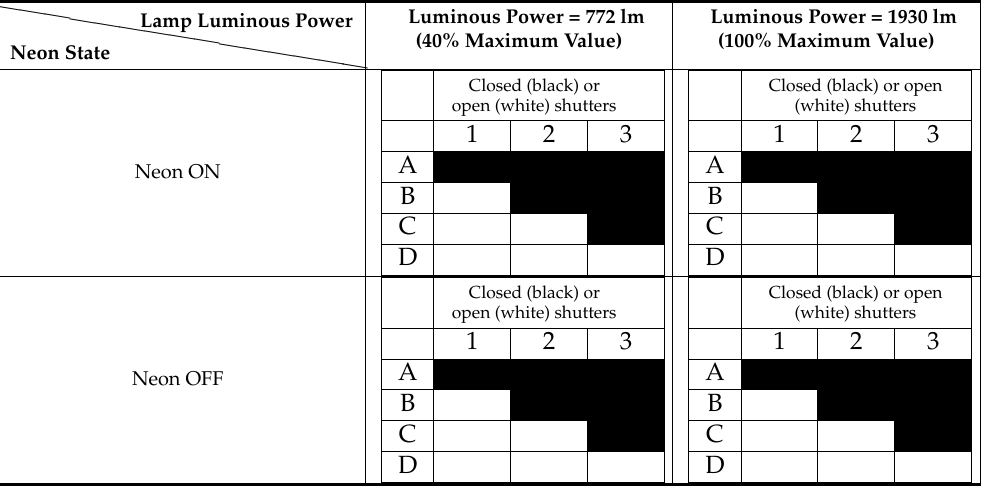
Table 2. Background illumination